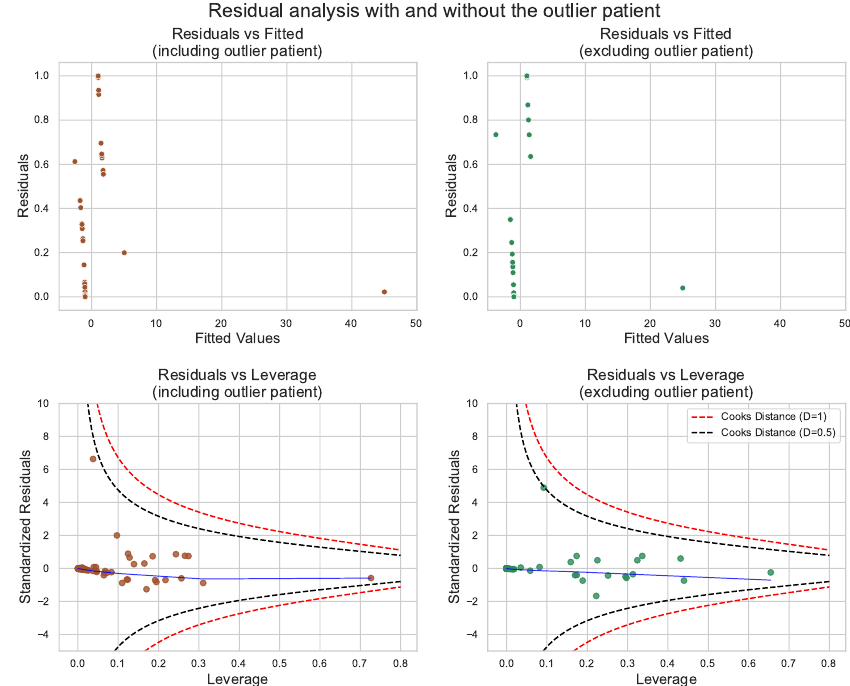
 /HYHUDJH Figure 8. Residual diagnostic plots for the models with and without the outlier patient. Outliers can be spotted as outfits in residual vs. fitted plots. The significance of outliers can be analyzed by residuals vs. leverage plots. Sole observations at the end of the blue line may have a significant impact on the model if they cross the dashed lines drawn for Cook’s distance. In the presented case, the outlier has not fallen outside the Cook’s boundaries, and as it is presented in the subplots on the right, its deletion does not change the model in any significant